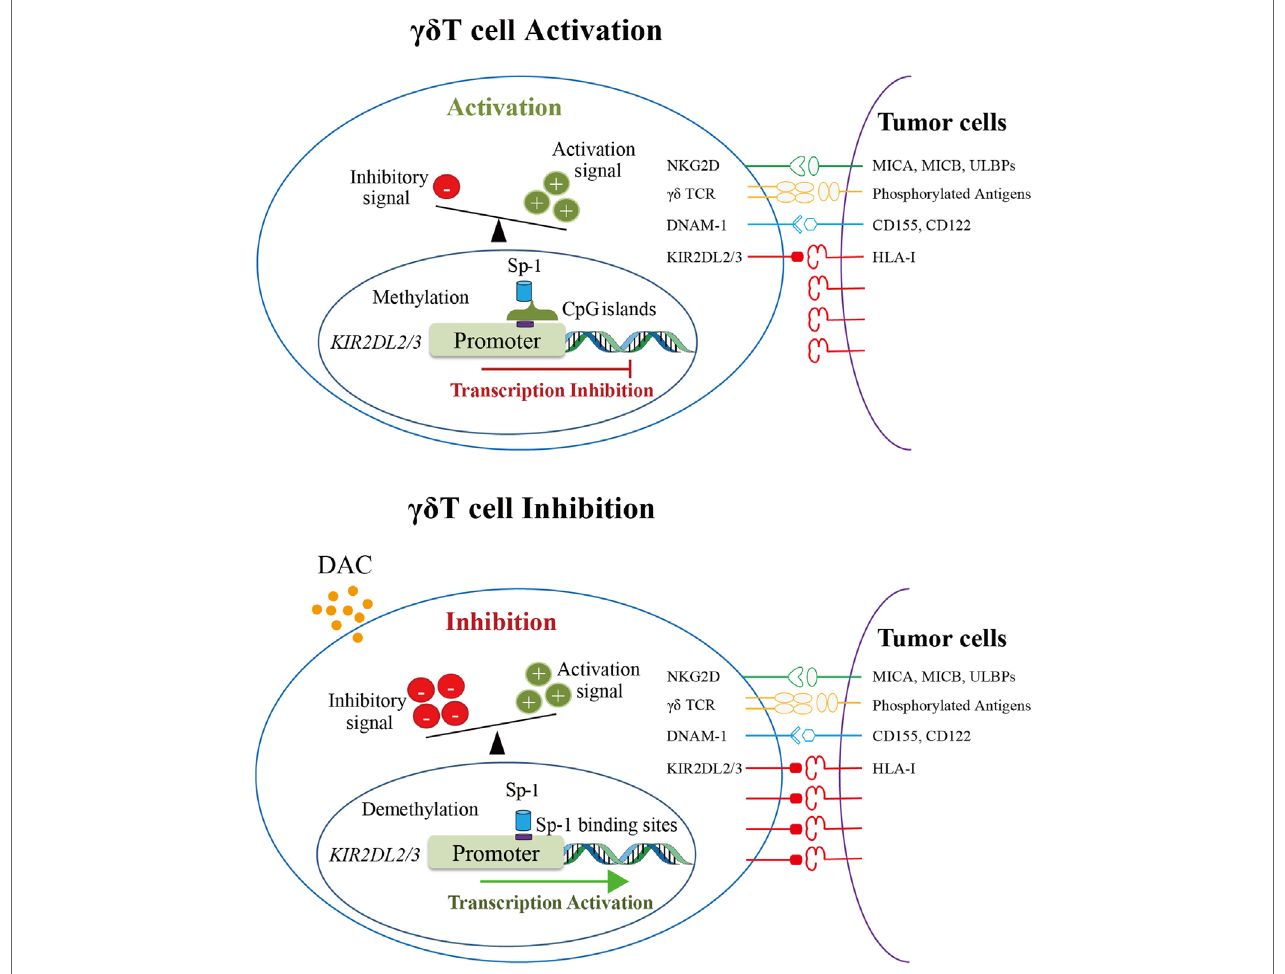
FigUre 6 | The proposed mechanism underlying the inhibition of gamma delta ( γδ ) T cell cytotoxicity by decitabine via promoting KIR2DL2/3 expression. The upper image shows the schematic diagram of γδ T cell activation. KIR2DL2/3 expression on γδ T cells was very low because the promoter of KIR2DL2/3 gene was methylated. When encountering tumor cells, γδ T cells were activated by the recognition of activation receptors and their ligands on tumors cells. The lower image shows the schematic diagram of γδ T cell inhibition by DAC. DAC demethylates the promoter of KIR2DL2/3 , which increases the binding of Sp-1 to its potential binding sites in the KIR2DL2/3 promoter, and then activates KIR2DL2/3 gene and protein expression. The upregulation of KIR2DL2/3 protein expression reduces the cytotoxicity of γδ T cells against tumor cells expressing HLA-I